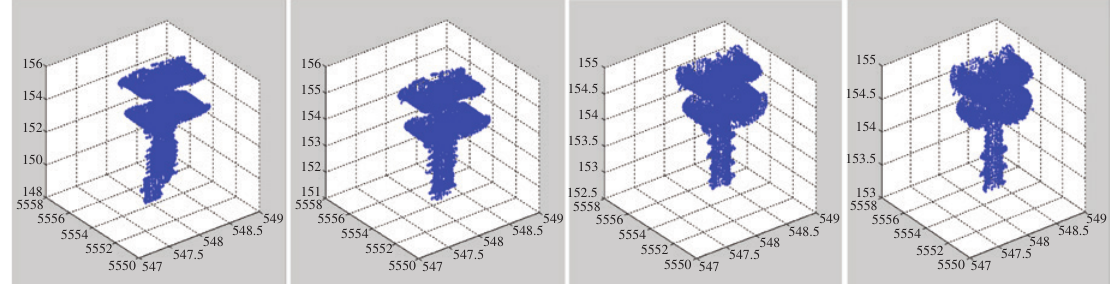
Figure 9: Point Cloud of a Test Device with Different Degrees of